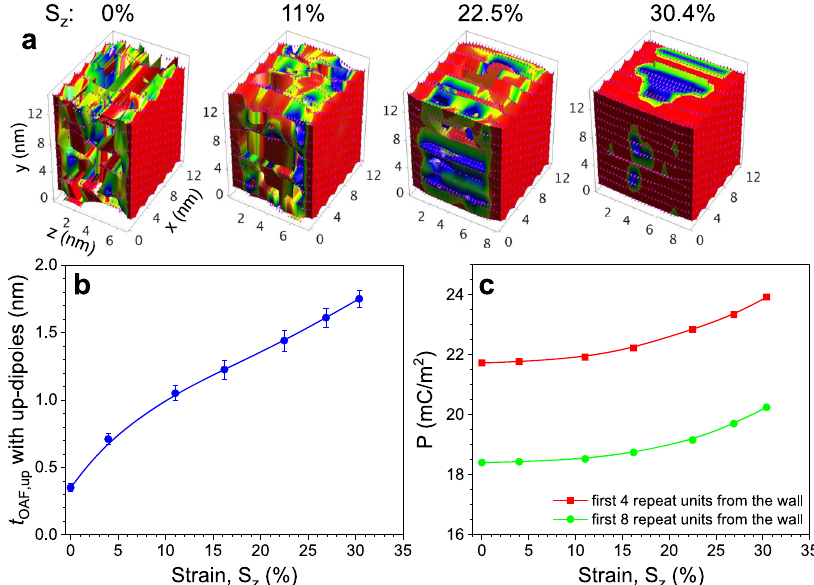
Fig. 5 Computer simulation of the direct piezoelectricity in PVDF. a The color-coded simulation slab for PVDF after equilibration at 300 K for 2 ns. The color scale represents PVDF units with positive dipole moments along the y -axis with values between zero (blue color) and 2.1 D (red color). The empty space in the pictures is comprised of negative dipoles. There are 12 chains along the x -axis, 12 chains along the y -axis, and 30 repeat units along the z -axis. The slab thickness along z is 6.8 nm. Chain ends are attached to both slab walls with a rigid C – C bond (dipole moment fi xed along the y -axis). The attachment points are organized in the same manner as the β crystal. The ab unit cell dimensions on the slab wall are a = 2.1 nm and b = 1.2 nm, respectively, which are about twice larger than the actual unit cell dimensions of the β crystal. The strain along z ( S z ) is 0%, 11%, 22.5%, and 30.4%, respectively. b The t OAF,up and c polarization along y ( P y ) for the fi rst 4 and 8 repeat units from the wall as a function of S z